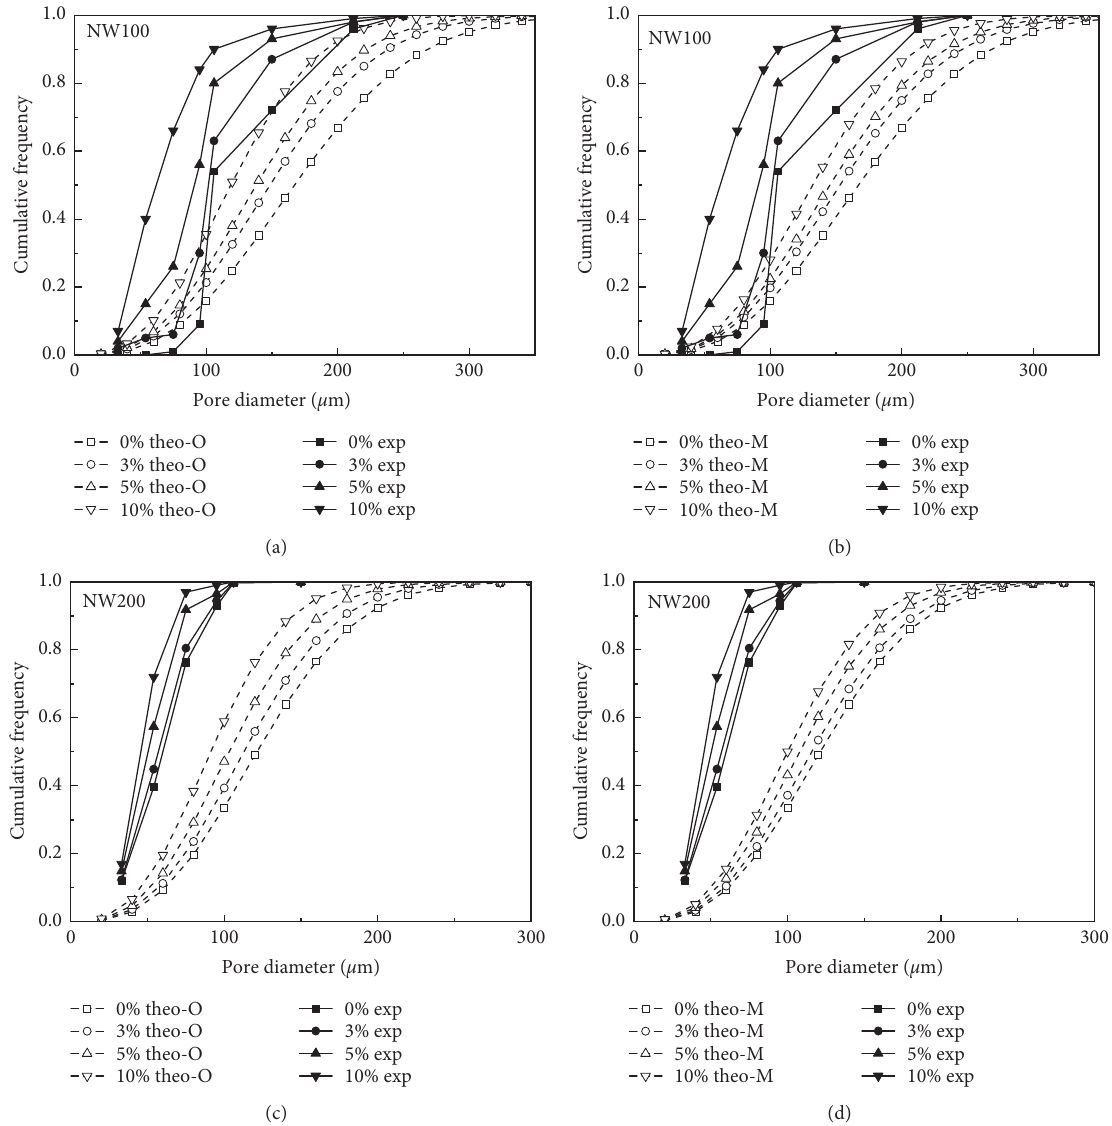
Figure 7: Experimental and theoretical PSDs of dry sieving test. (a) Experimental and theoretical PSDs of the original model for NW100. (b) Experimental and theoretical PSDs of the modified model for NW100. (c) Experimental and theoretical PSDs of the original model for NW200. (d) Experimental and theoretical PSDs of the modified model for